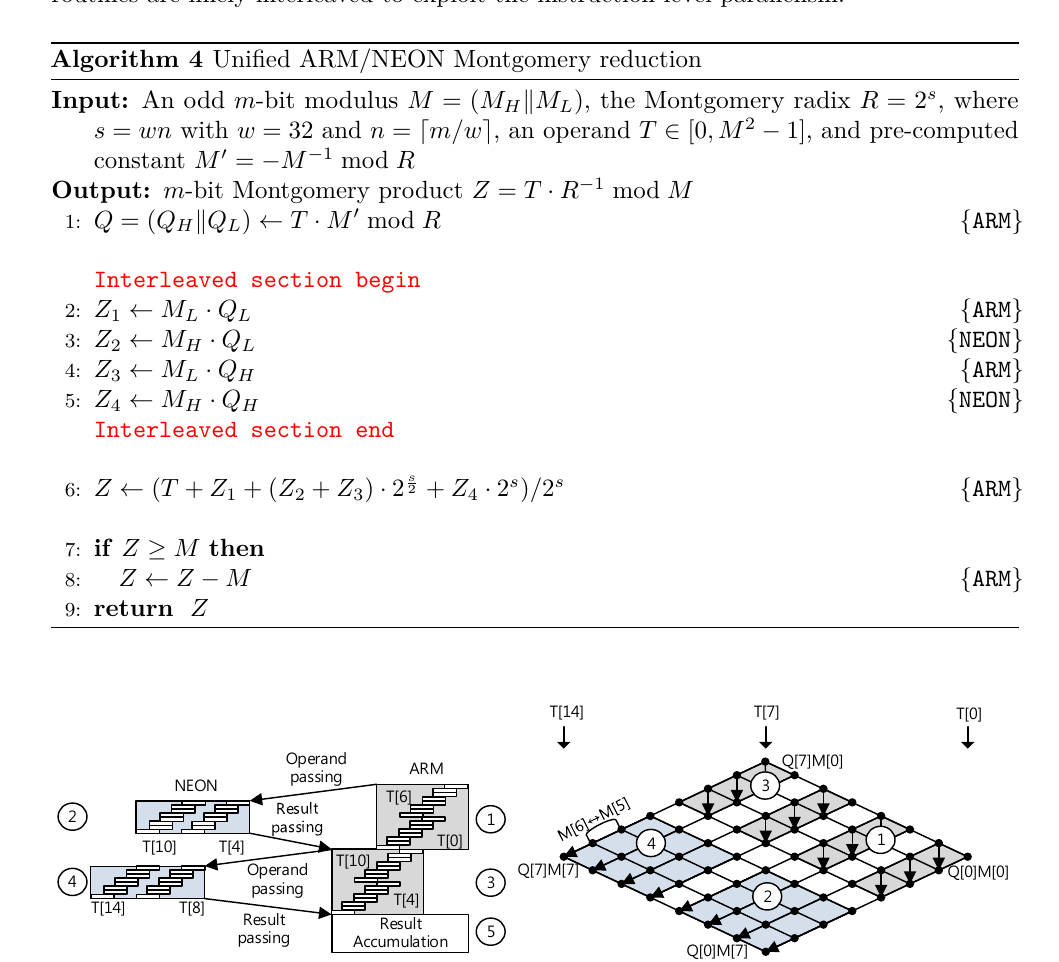
Figure 2: Unified 256-bit ARM/NEON Montgomery reduction at the word-level (8-word operand), 1 (cid:13) 3 (cid:13) : two sub-products on ARM; 2 (cid:13) 4 (cid:13) : two sub-products on NEON; 5 (cid:13) : result